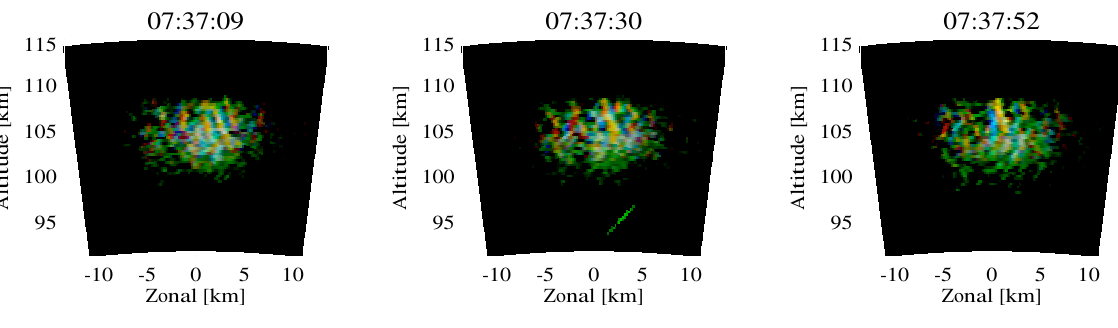
Fig. 5. Radar images of EEJ events. The phase calibration has been done using a meteor-trail echo and the mean EEJ characteristics. Each frame has been obtained with 5s exposure.